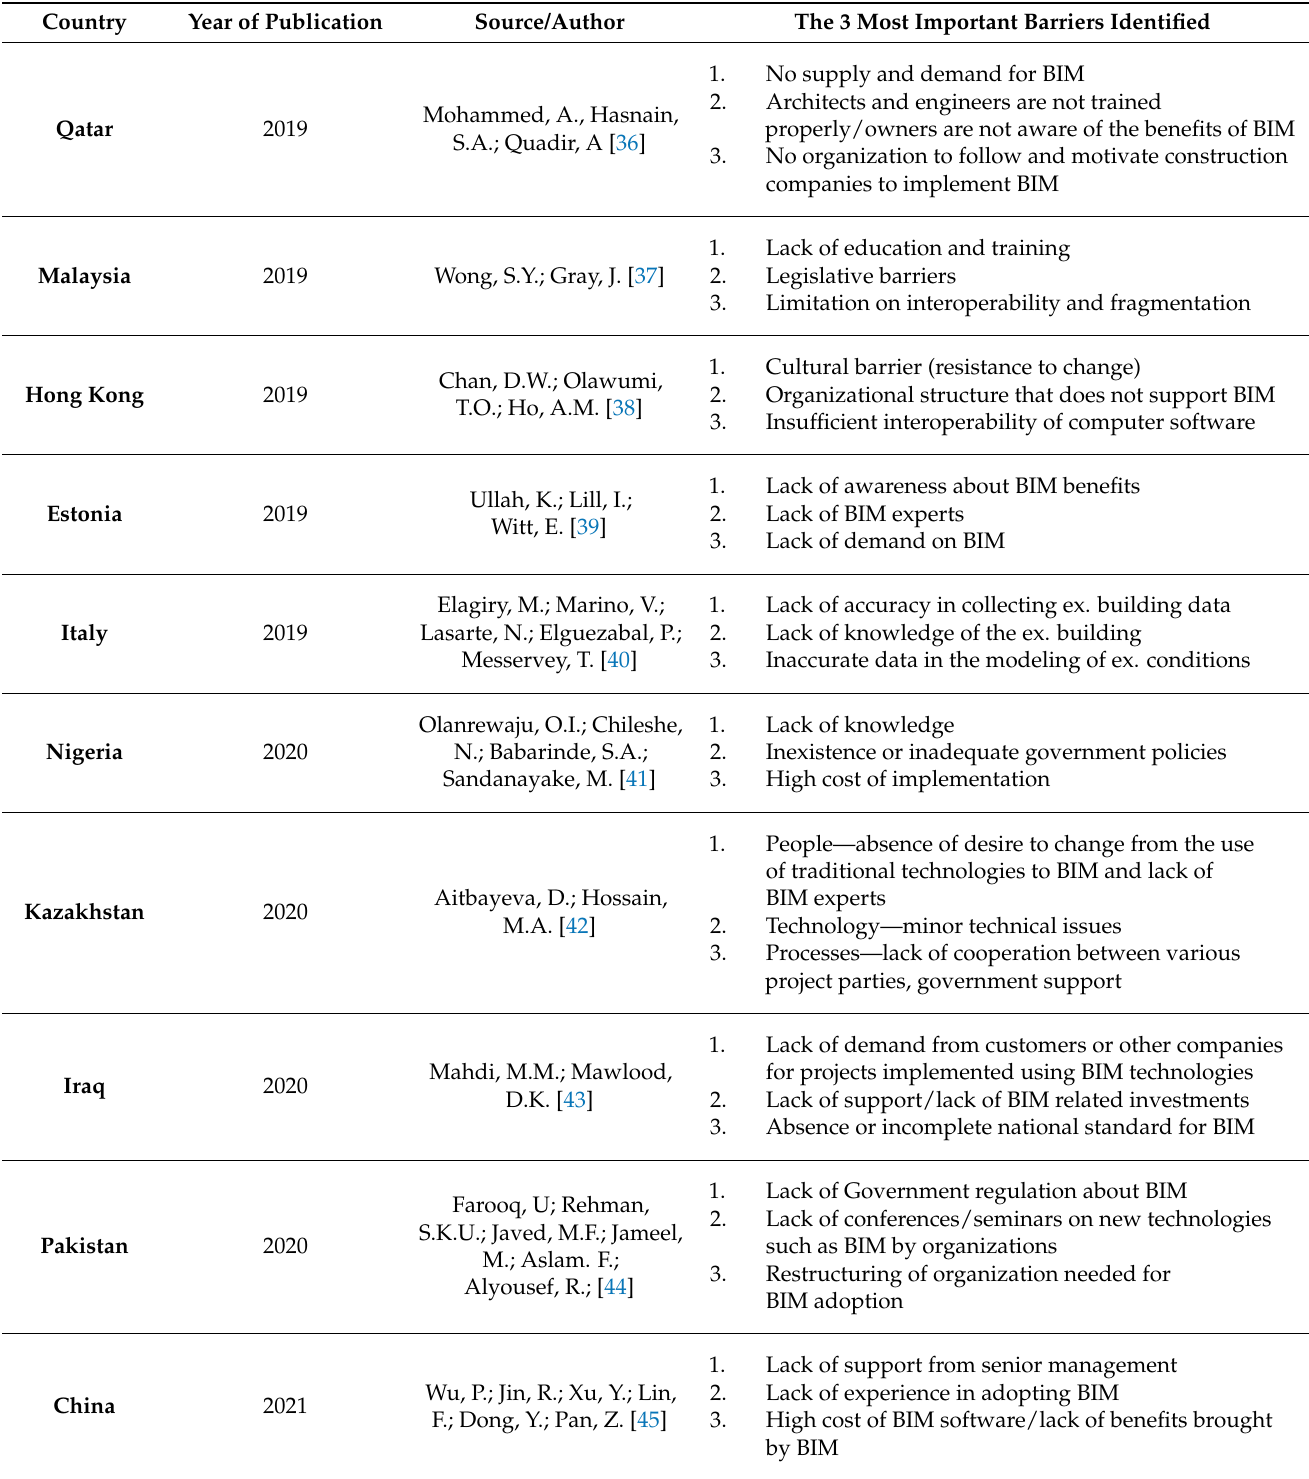
Table 1. The three most important barriers to BIM implementation identified in selected countries (2019–2021).